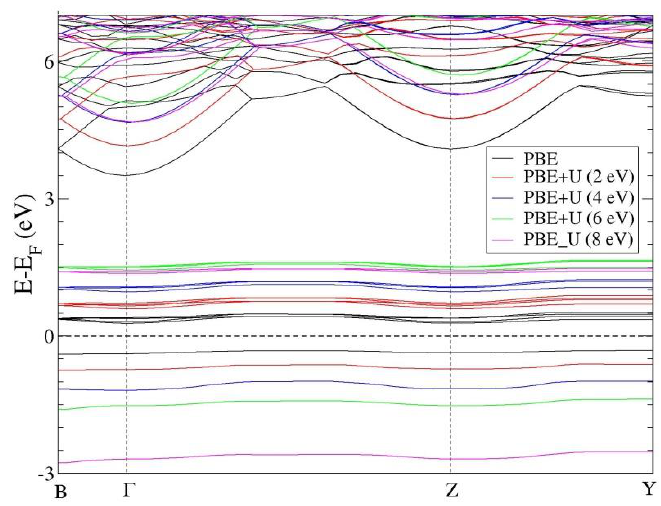
Figure 3. The electronic band structure of copper pyrophosphate calculated using PBE and PBE+U. The Fermi level (dashed line) was set to zero. The Fermi level (dashed line) was set to